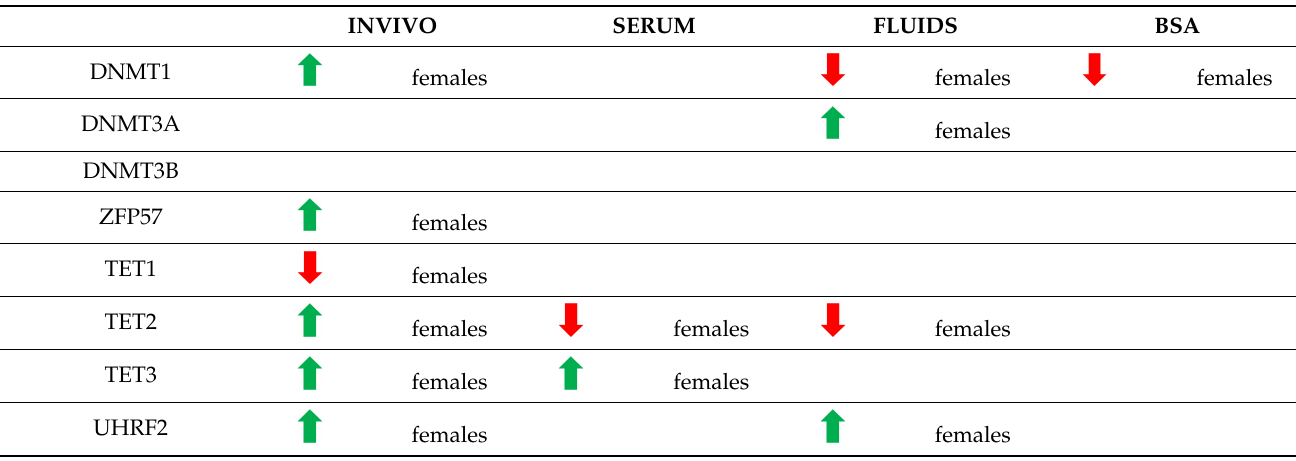
Table 2. Sexually dimorphic methylation tiles ( p < 0.05 after correction and methylation values differences over 10%) overlapping genes involved in the DNA methylation